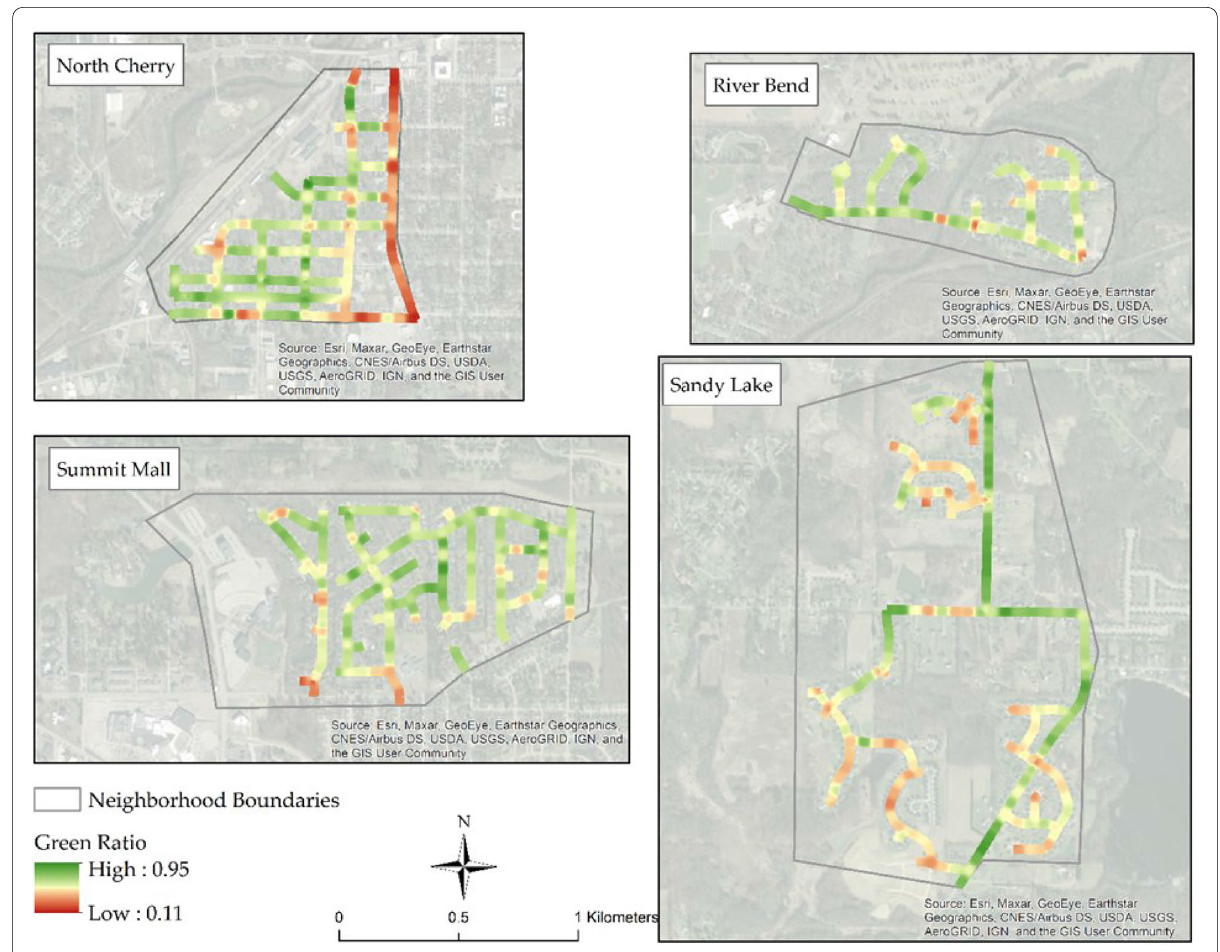
Fig. 10 Spatial distribution of greenness